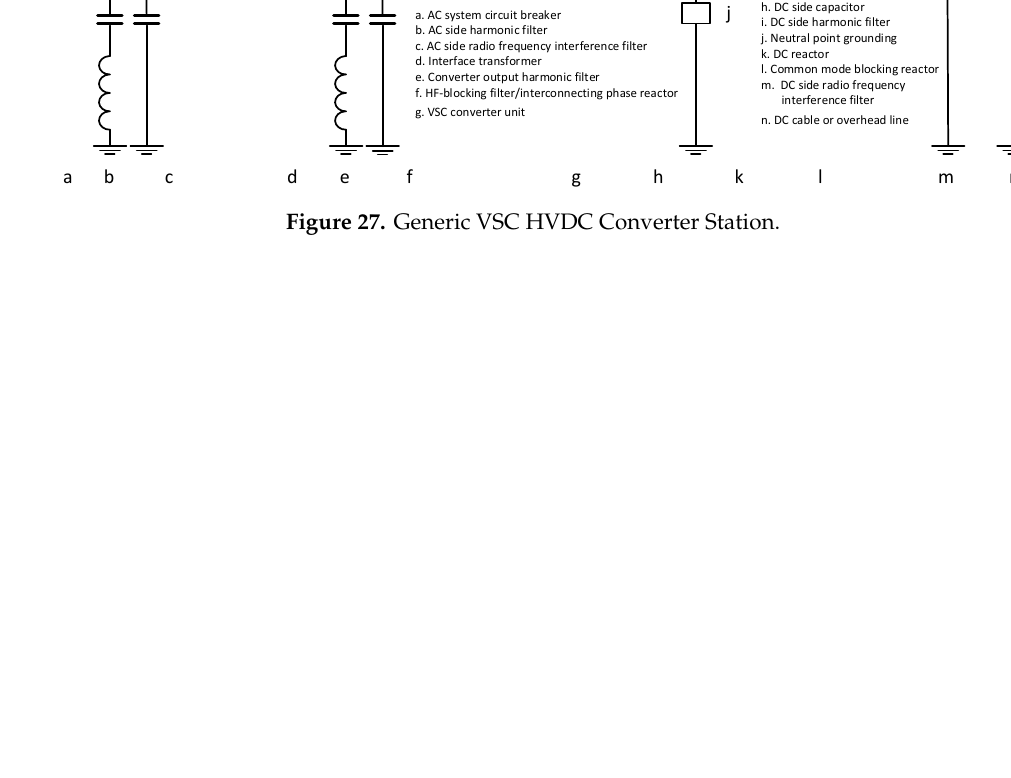
Figure 28. MurrayLink VSC HVDC Converter Station.